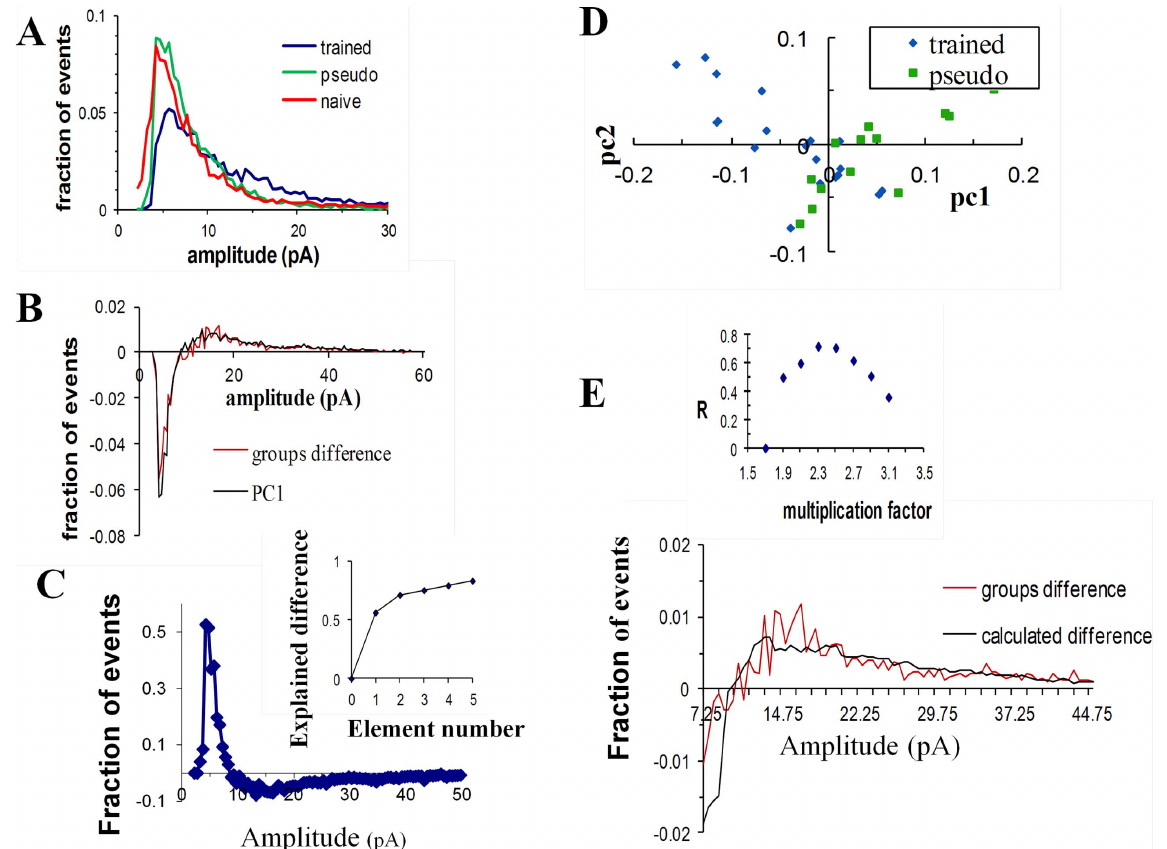
Figure 1. The learning-induced modulation of the excitatory unitary synaptic events amplitude is dominated by a single process in which the events amplitude was doubled. A. For each neuron an amplitude distribution curve was reconstructed from the mEPSC amplitudes and normalized (data taken from [17]). Averaged amplitude histograms, were calculated for all neurons from the three groups. Notably, a much more significant portion of events in the trained group are of high values. B. The curve calculated by subtracting the averaged pseudo amplitude distribution curve from the averaged trained amplitude distribution curve (red) match the first component calculated by PCA (black). The PCA component was scaled in the Y-axis, such that the best fit is achieved. We reasoned that such scaling is valid since this component is used by the PCA inside a linear combination. C. The first (major) component calculated by the PCA analysis. Inset: The first component accounts for 60% of the differences between amplitude distributions of all cells. D. For each cell the weight for the first component (X-axis) was drawn against its weight for the second component (Y-axis). Only the weights of the first component are significantly different between groups. E. For each multiplication factor a different curve that describes the difference between groups assuming a multiplication model was calculated. The calculated curve assuming multiplication factor of 2.2 (black) matched the curve that describes the main difference between groups (red). Inset: the correlation coefficient was calculated for each multiplication factor (for calculation of r only amplitudes . 7pA were used, since at lower amplitudes, multiplication factors bigger than two requires unavailable data in amplitudes , 3pA, see Methods).